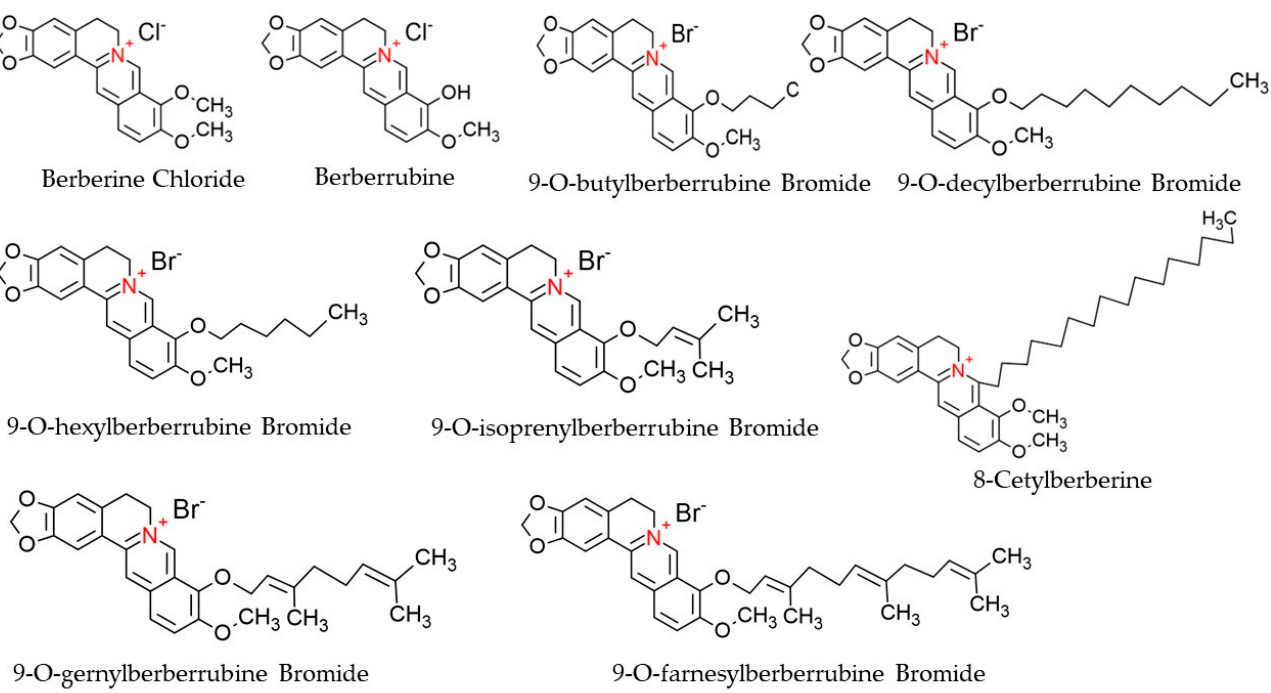
Figure 3. Chemical structures of Berberine and its derivatives.